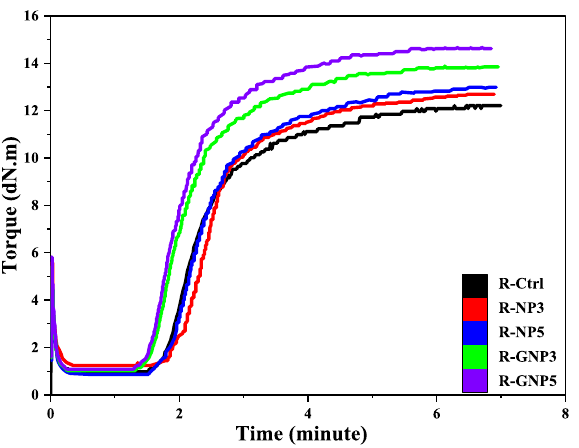
Figure 5. Comparative curing behaviors of the NBR nanocomposites at 3 and 5 wt% of pure and VTES grafted nano silica.